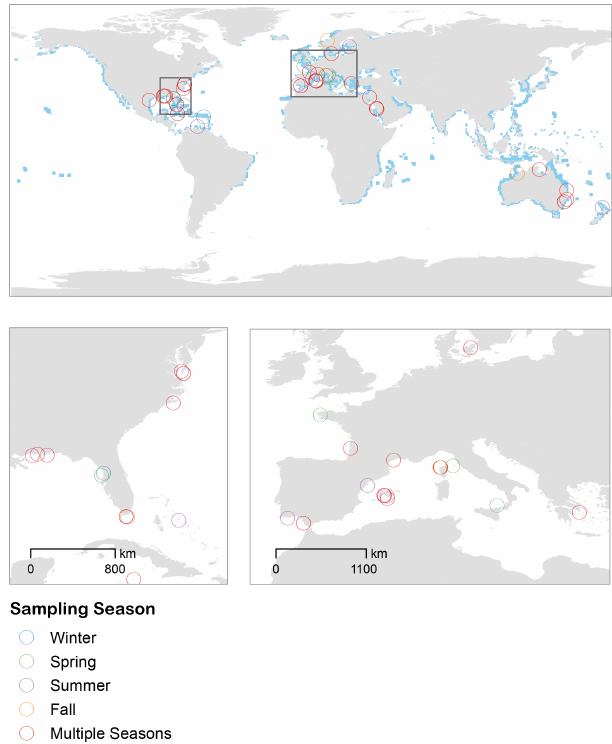
Figure 1. Studies included in the analyses span temperate to tropi- cal ecosystems, with many studies occurring in the western Atlantic and Mediterranean. Most studies measured seagrass metabolism during the spring and summer months, while fewer studies mea- sured the metabolism in fall and winter conditions. Blue pixels rep- resent the distribution of seagrasses from UNEP-WCMC and Short